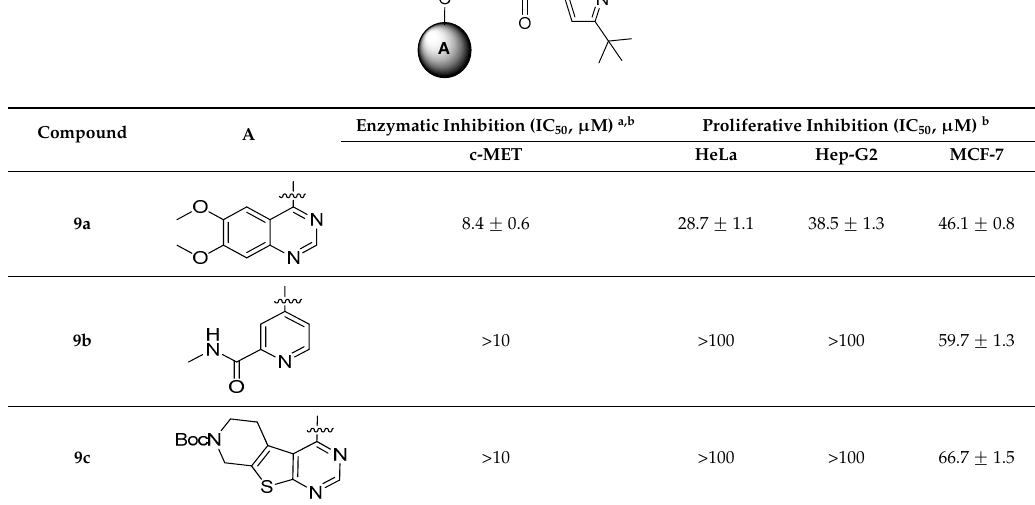
Table 1. Enzymatic and cellular results for compound 9a – c .